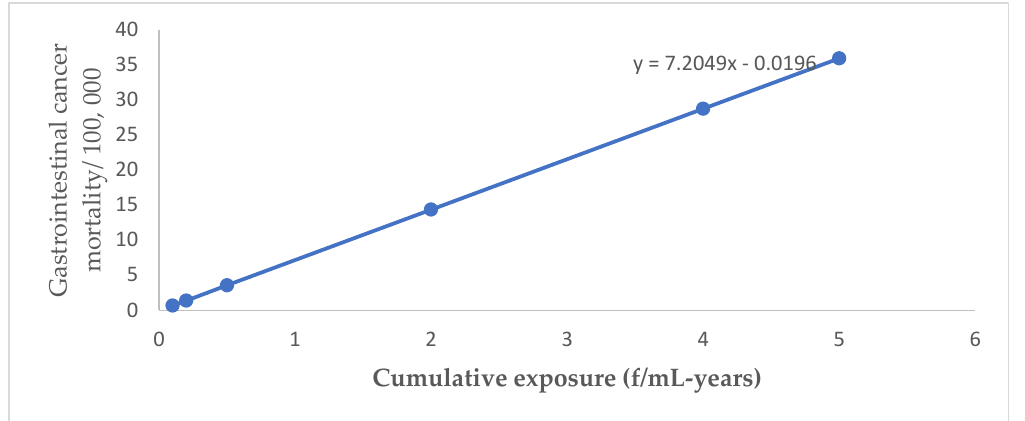
Figure 3. Gastrointestinal cancer mortality by cumulative exposure linear regression equation.